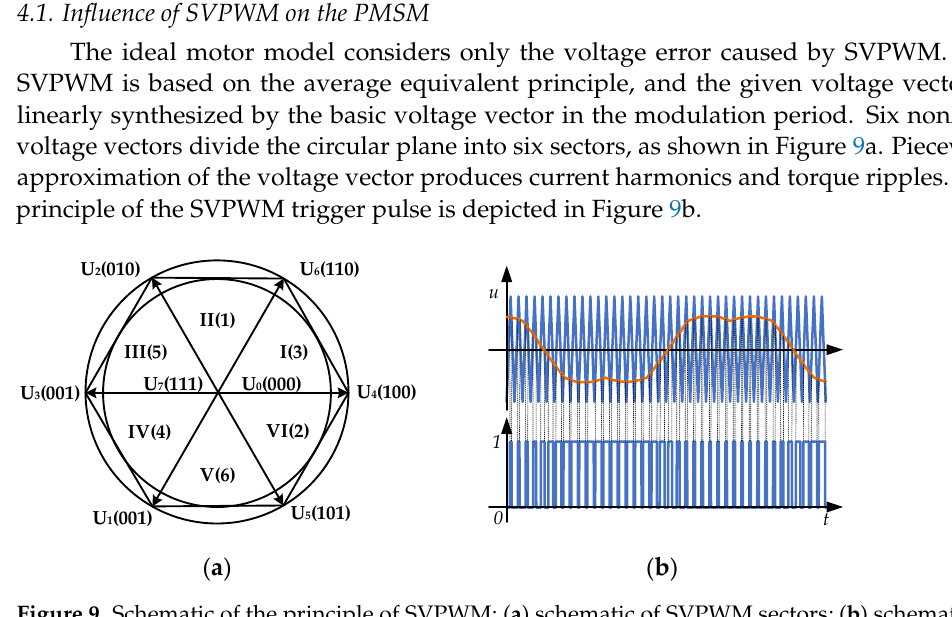
Figure 9. Schematic of the principle of SVPWM: ( a ) schematic of SVPWM sectors; ( b ) schematic of pulse generation.